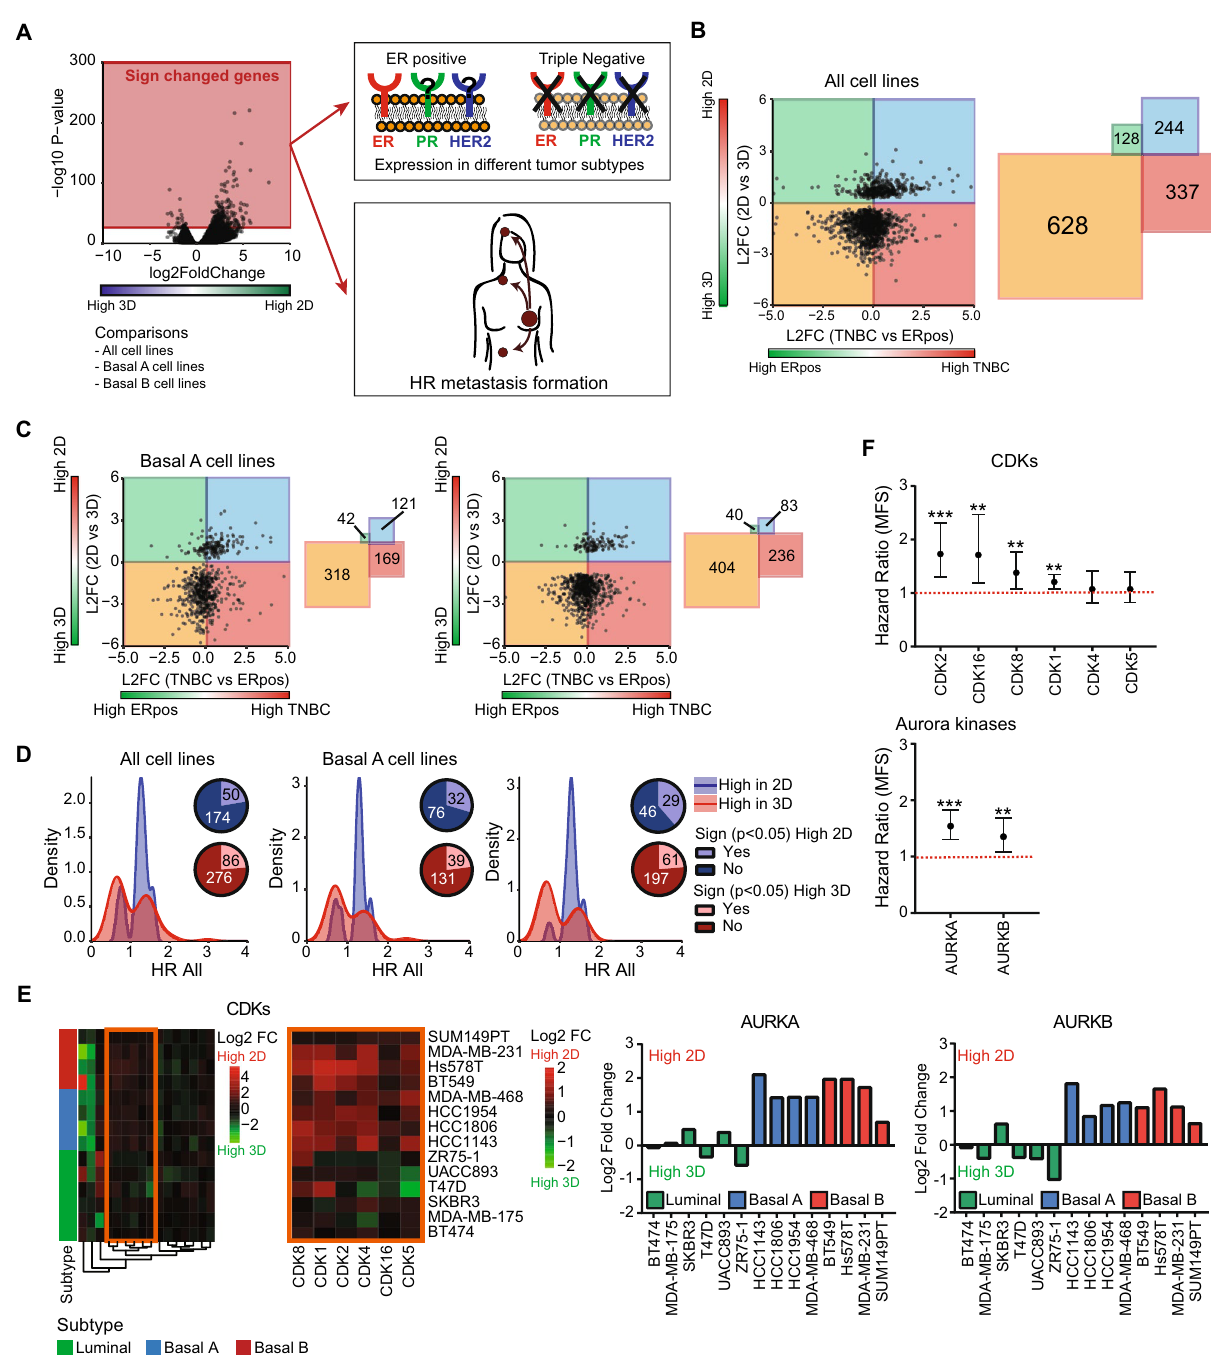
Figure 3. Role of DEGs in breast cancer aggressiveness and metastasis formation. ( A ) Significantly DEGs comparing all cell lines, basal A cell lines or basal B cell lines were selected using a paired cell line analysis per subtype, p < 0.01. For these genes, the expression in different tumor subtypes as well as the relation to metastasis formation was determined. ( B ) Log2 fold change of DEGs (paired analysis of all cell lines, p < 0.01) comparing 2D to 3D cell cultures versus log2 fold change comparing TNBC to ER positive primary tumors (left). Number of genes in each quadrant (right). ( C ) Log2 fold change of DEGs (paired analysis of basal A and basal B cells, p < 0.01) comparing 2D to 3D cell cultures versus log2 fold change comparing TNBC to ER positive breast tumors (left). Number of genes in each quadrant (right). ( D ) Density plot of DEGs (paired analysis of all, basal A and basal B cell lines respectively, p < 0.01) with a significant hazard ratio (HR). Blue = density plot for DEGs with increased expression in 2D cultures. Red = density plot for DEGs with increased expression in 3D cultures. Venn diagrams show the fraction of DEGs showing a significant HR. ( E ) Heatmap (Euclidean distance, complete linkage) of log2 fold change of CDK expression levels comparing 2D to 3D cultures (orange cluster is enlarged on the right) and log2 fold change of aurora kinase A and B comparing 2D to 3D cultures for different cell lines. ( F ) Hazard ratios and 95% confidence interval (CI) for CDKs higher expressed in 2D and aurora kinase A and